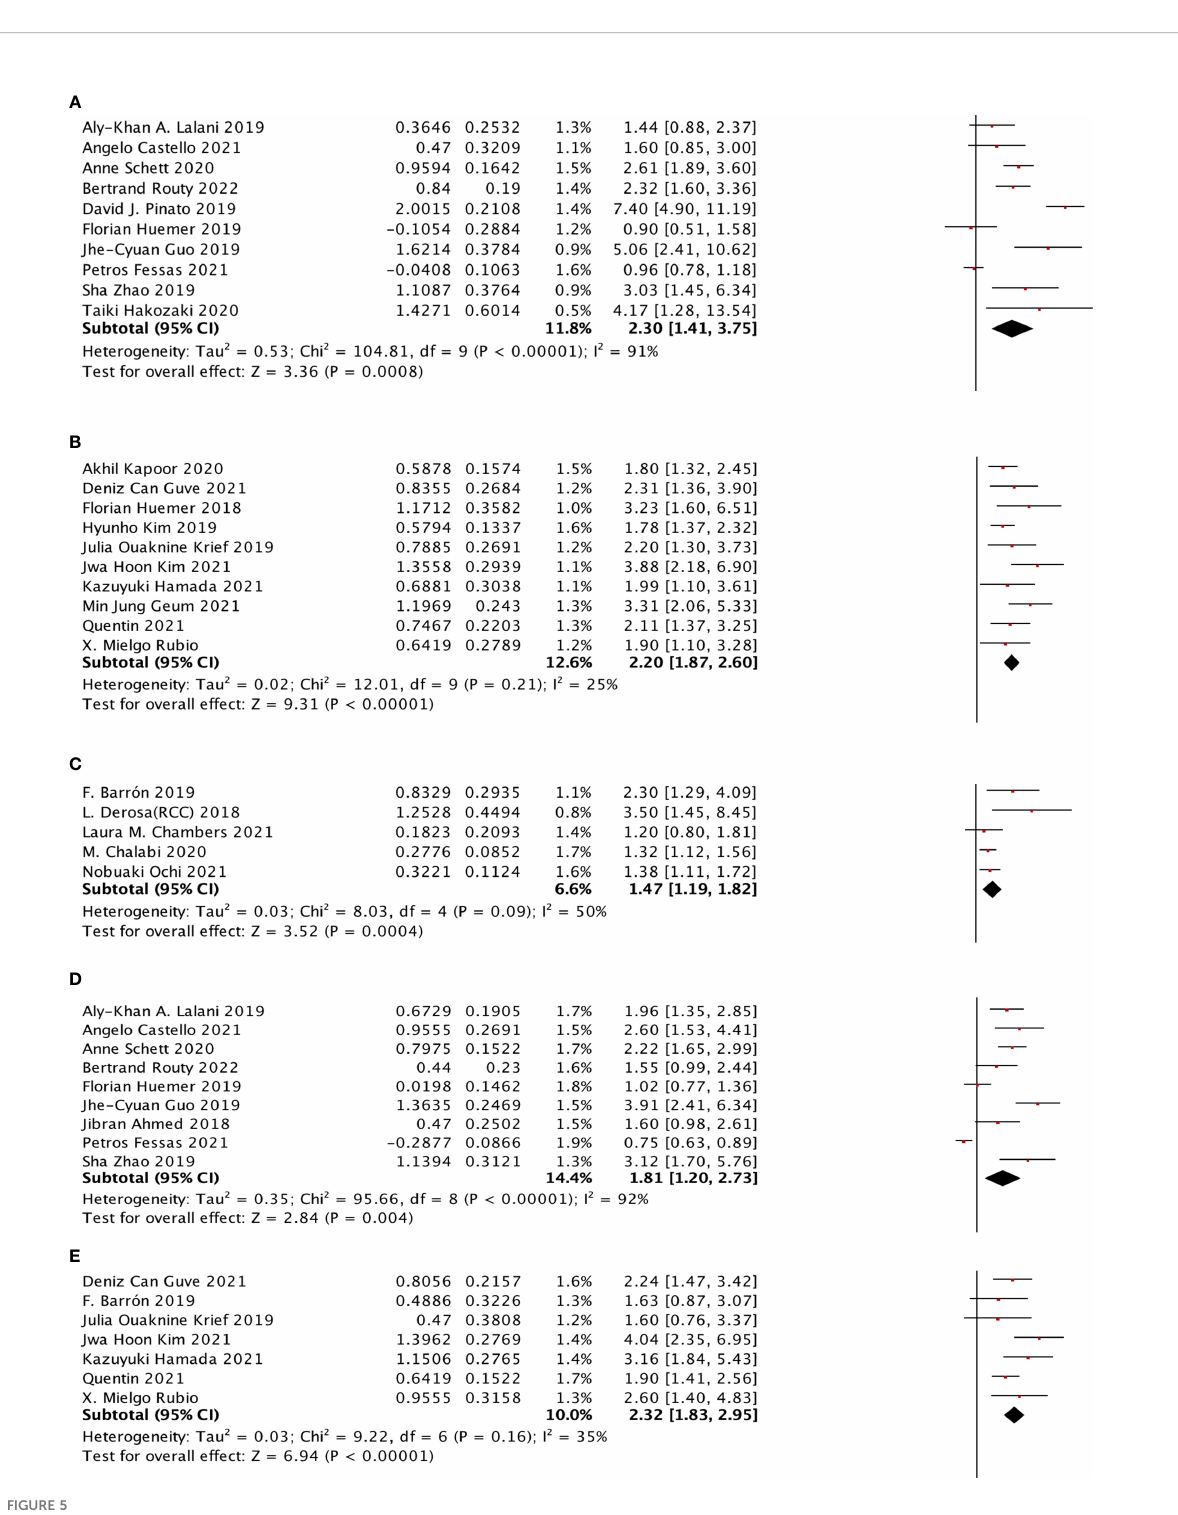
FIGURE 5 The subgroup analysis between ATB use and different immune checkpoint inhibitors of cancer patients treated with ICIs. (A) The association between ATB use and OS in cancer patients treated with the combination of PD-1 inhibitor and PD-L1 inhibitor. (B) The association between ATB use and OS in cancer patients treated with PD-1 inhibitor. (C) The association between ATB use and OS in cancer patients treated with PD- L1 inhibitor. (D) The association between ATB use and PFS in cancer patients treated with the combination of PD-1 inhibitor and PD-L1 inhibitor. (E) The association between ATB use and PFS in cancer patients treated with PD-1